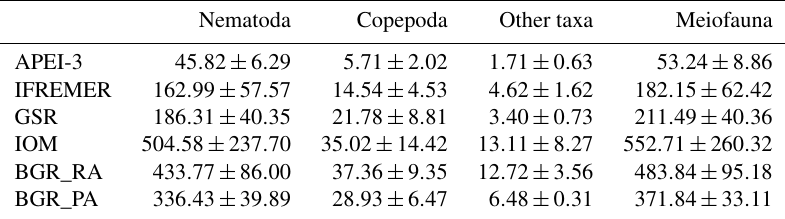
Table 3. Average meiofauna densities (individuals 10cm − 2 ) and standard deviation for the different CCZ areas. Copepoda includes both adults and nauplius larvae. Other taxa are meiofaunal taxa excluding nematodes and